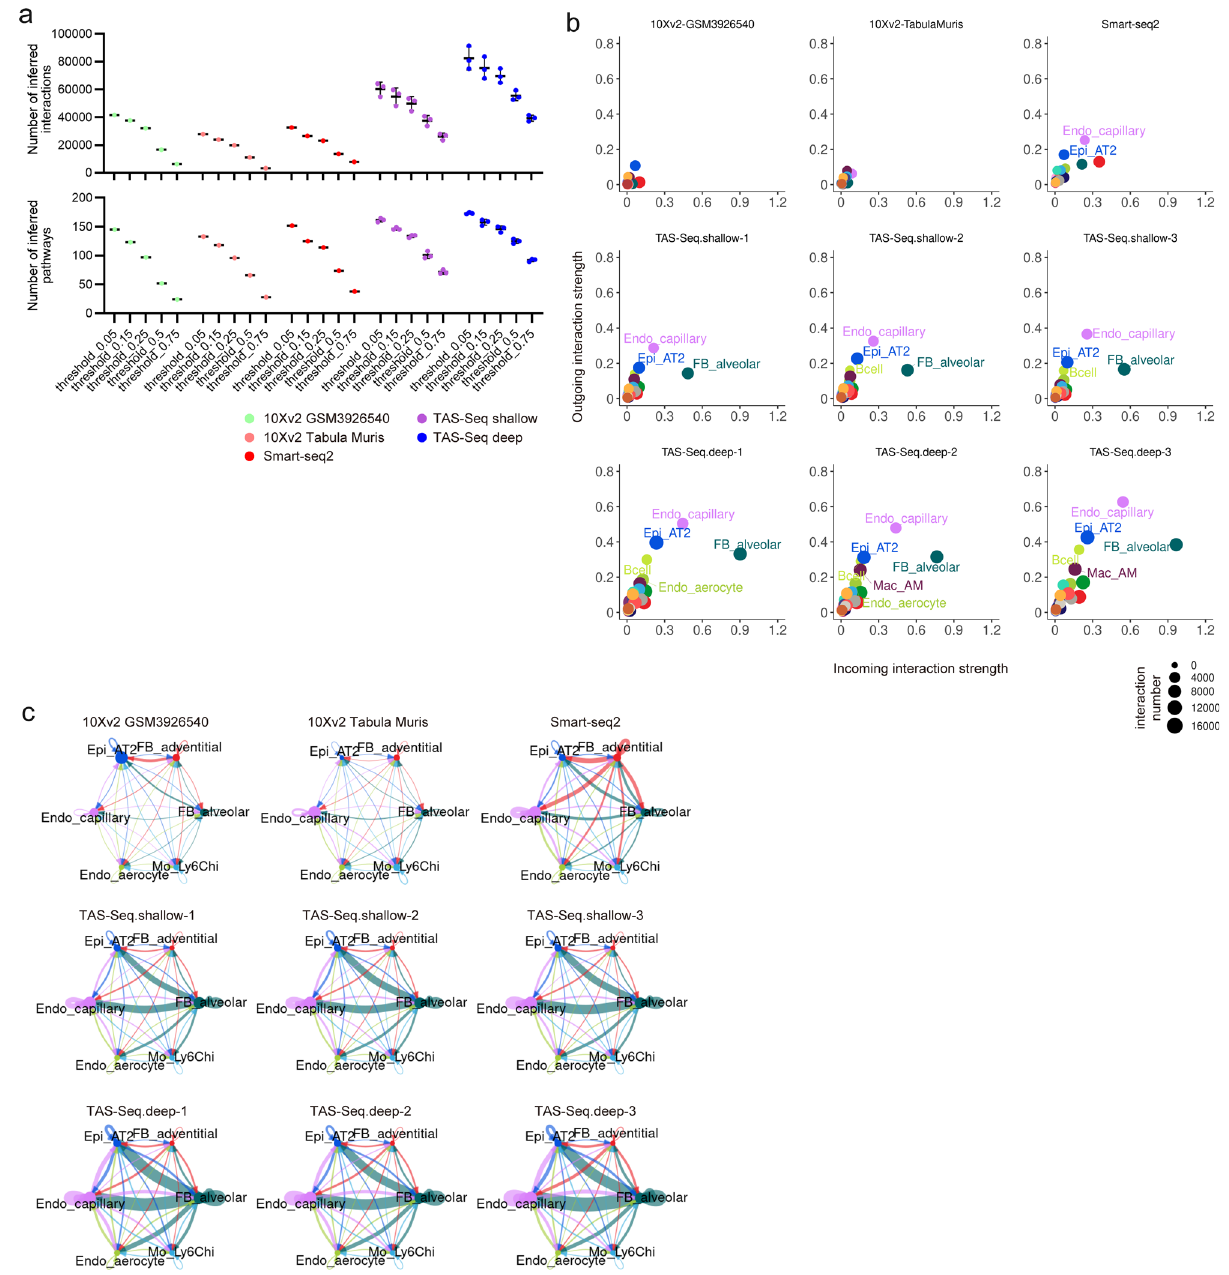
Fig. 5 TAS-Seq identi fi es more cell – cell interactions than 10X v2 and Smart-seq2 in murine lung tissue. a Changes of the number of inferred interactions/pathways of cell – cell interaction network of each scRNA-seq dataset of murine lung predicted by CellChat when the threshold of genes of which minimum fraction of expressed cells within each cell subset. Error bars show mean ± SD in TAS-Seq.shallow and TAS-Seq.deep samples. b Scatter plot of incoming (target) and outgoing (source) signaling strength within the cell – cell interaction network of each cell subset (minimum expression of genes in each cell subset ≥ 0.15). Dot size represents the sum of incoming and outgoing signals in each cell subset. Capillary endothelial cells, alveolar type 2 cells, and alveolar fi broblasts were strongly connected in the TAS-Seq and Smart-seq2 dataset networks, and cell subsets were more strongly connected in the TAS-Seq dataset than in the Smart-seq2 dataset. The overall connections were weak in 10X v2 datasets. c Circle plot visualizations of cell – cell interaction network of each scRNA-seq dataset of murine lung within particular cell subsets. Circle sizes represent the cell number of each subset. Wider edge means stronger communication, and edge width was normalized among all datasets. See also Supplementary Fig. 12b for the cell – cell interaction network of all cell subsets. Abbreviations of cell subsets were shown in Supplementary Data